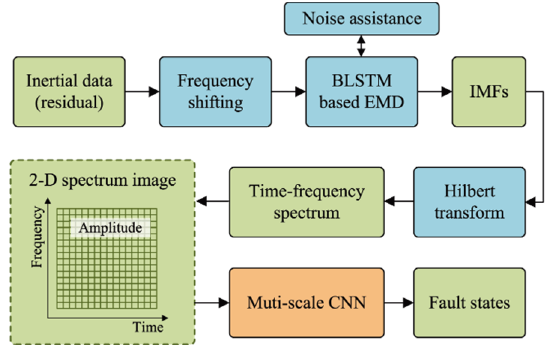
Figure 1. Process of the proposed fault diagnosis method.